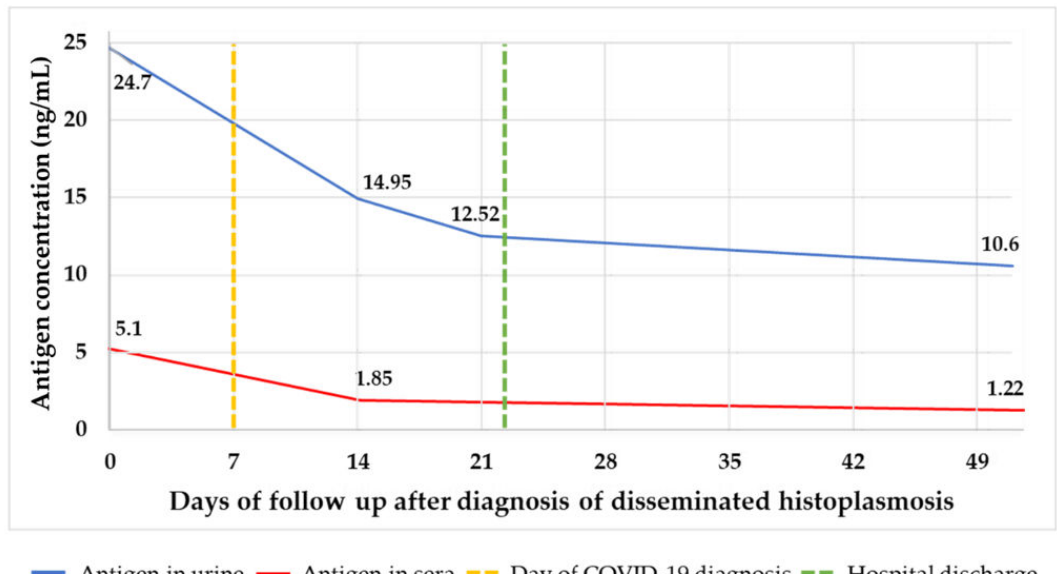
Figure 3. Follow-up using Histoplasma antigen testing in a patient with disseminated histoplasmosis and